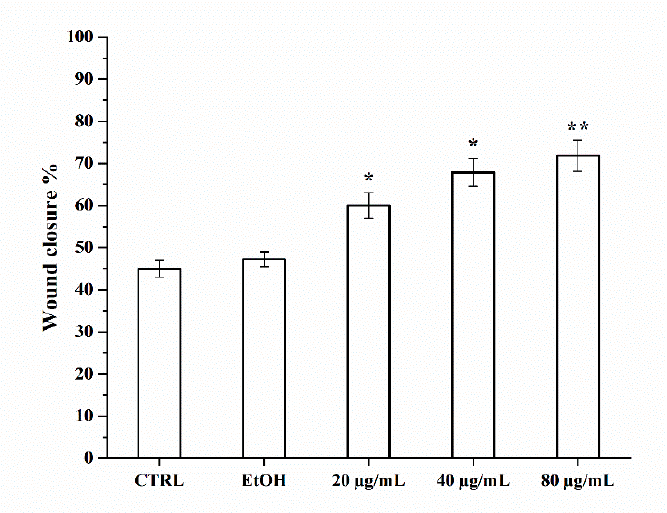
Figure 3. Wound-healing repair after P. spinosa extract (20–80 μ g/mL) and its vehicle alone (EtOH) treatment. The graph shows the percentage of wound closure compared to the untreated control (CTRL) after 48 h. The values reported are the mean ± SD of three independent experiments. * p < 0.05, ** p < 0.001 vs. CTRL (Student’s t